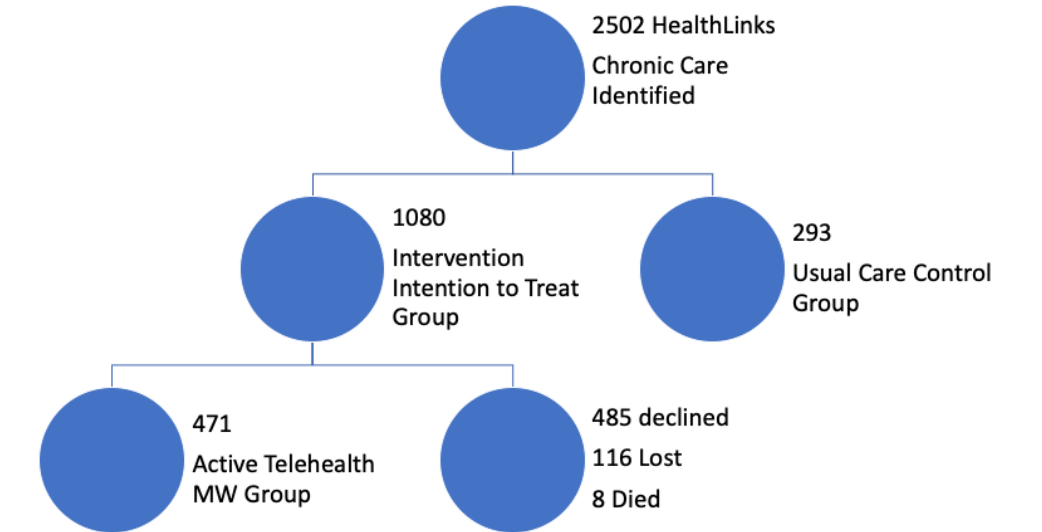
Figure 3. MonashWatch pragmatic clinical evaluation participants. Intention-to-treat, including active telehealth, and usual care cohort allocation in the MonashWatch pragmatic evaluation. MW: MonashWatch.